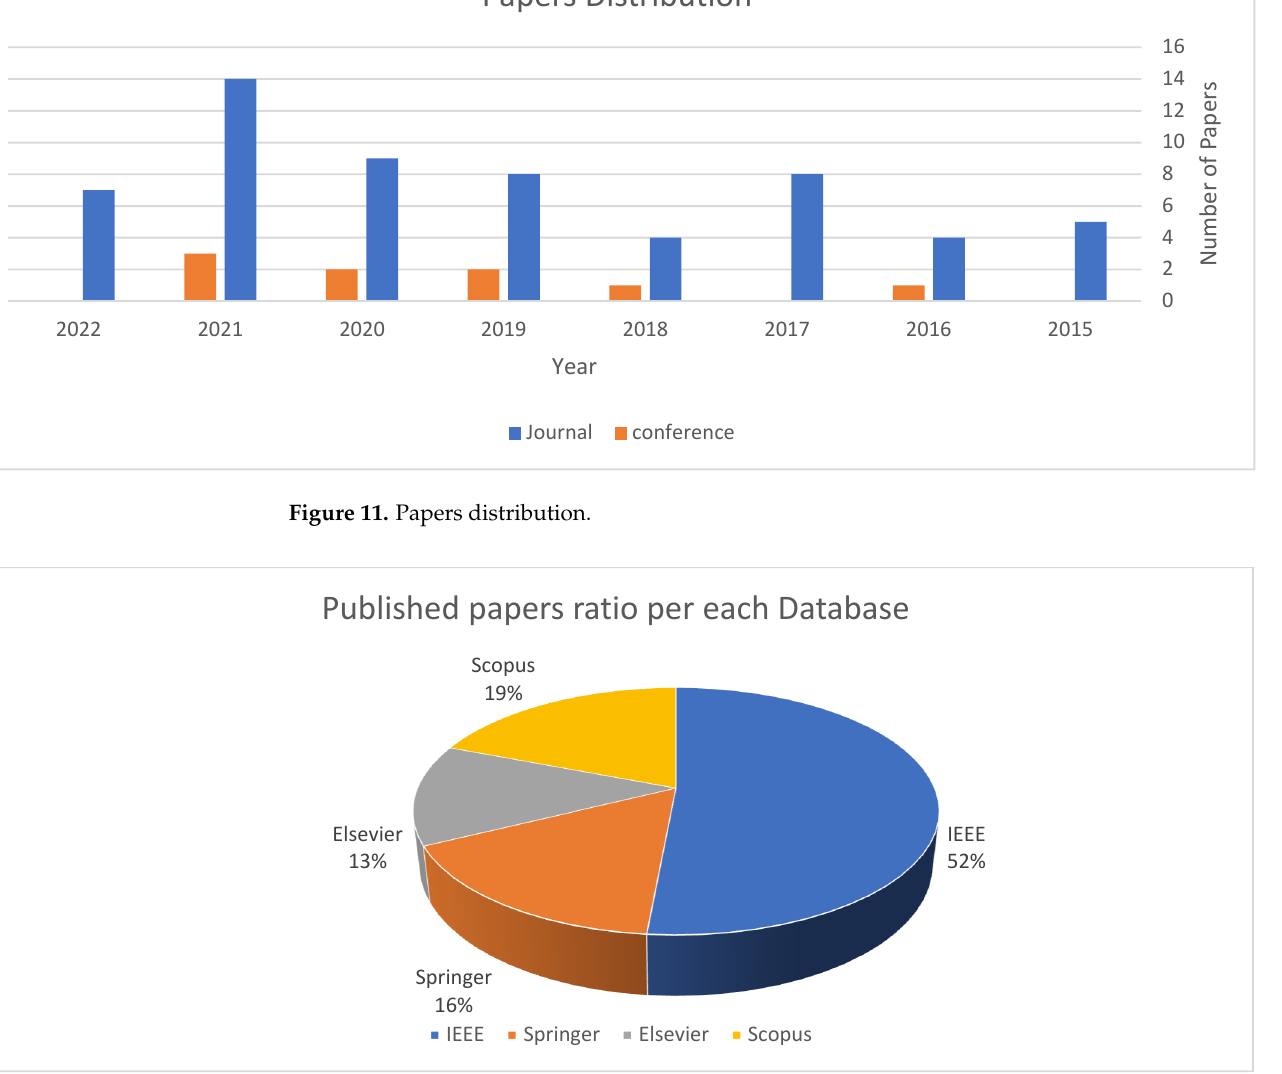
Figure 12. Papers ratio for each